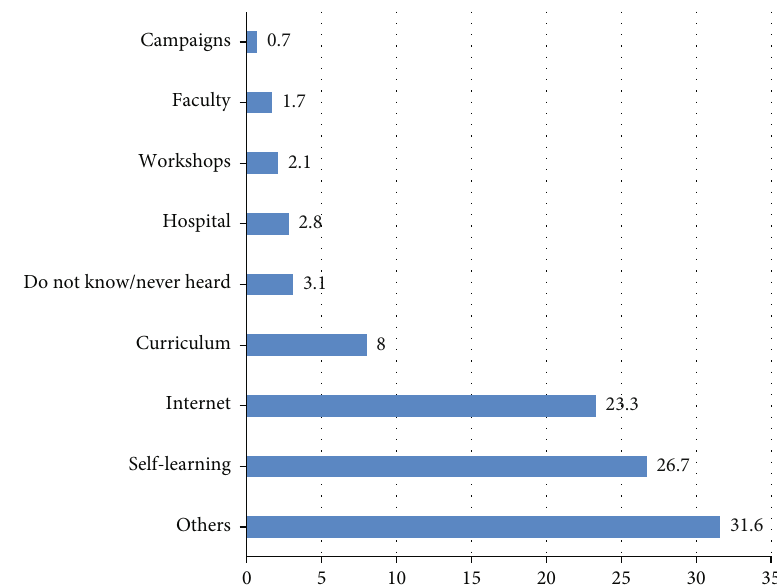
Figure 1: Representation of the identi fi ed sources of information for cervical cancer as provided by participants, in increasing order of